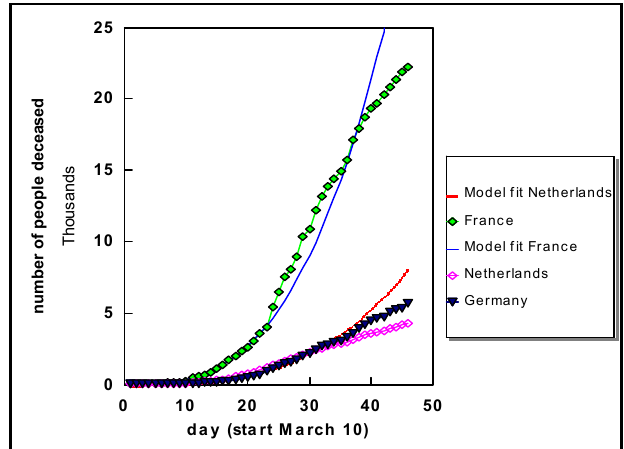
Figure 3. Number of deaths (ordinate) during the period 10 March–24 April 2020 for France, the Netherlands, and Germany, as well as exponential fits, in the present case cubic, to the data for France and the Netherlands. The cubic fit to the German data is shown and discussed at a later stage in this paper (section 4).